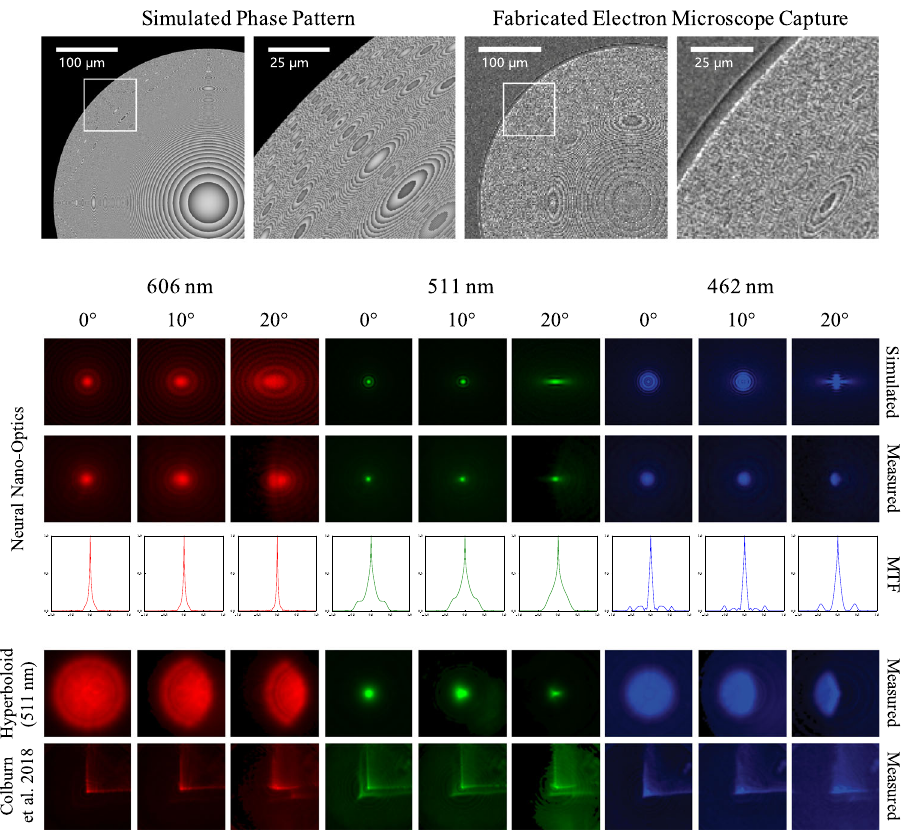
Fig. 3 Meta-optics characterization. The proposed learned meta-optic is fabricated using electron-beam lithography and dry etching, and the corresponding measured PSFs, simulated PSFs, and simulated MTFs are shown. Before capturing images, we fi rst measure the PSFs of the fabricated meta- optics to account for deviations from the simulation. Nevertheless, the match between the simulated PSFs and the measured PSFs validates the accuracy of our metasurface proxy model. The proposed learned design maintains consistent PSF shape across the visible spectrum and for all fi eld angles across the FOV, facilitating downstream image reconstruction. In contrast, the PSFs of the traditional meta-optic and the cubic design proposed by Colburn et al. 10 both exhibit severe chromatic aberrations. The red (606 nm) and blue (462 nm) PSFs of the traditional meta-optic are defocused and change signi fi cantly across the FOV. The PSFs for the cubic design exhibit long tails that leave post-deconvolution